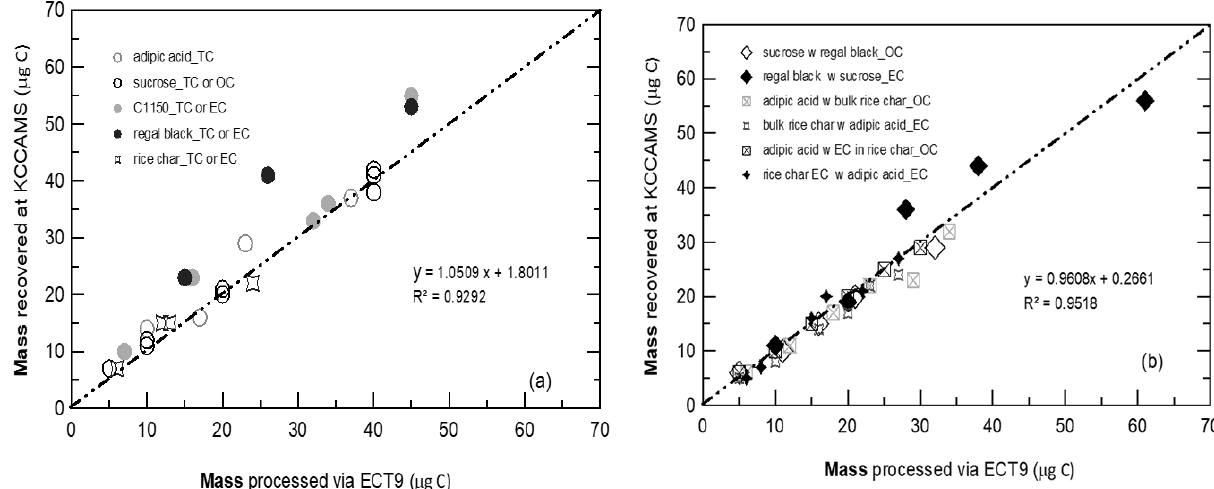
Figure 2. Cross-validation of carbon mass processed by the ECT9 protocol and collected via cryo-trapping at ECCC and the carbon mass retrieved during the purification and graphitization on a KCCAMS vacuum line. Carbon fractions (OC, EC, or TC) were isolated from two reference materials for OC (sucrose, adipic acid) and for EC (regal black, C1150) and one OC and EC mixture (rice char). Most of the points deviating from the 1 : 1 line are carbon-rich reference materials, e.g., regal black and C1150 ( > 90% TC), wherein there are usually greater uncertainties in initial mass determination via weighing using microbalance.